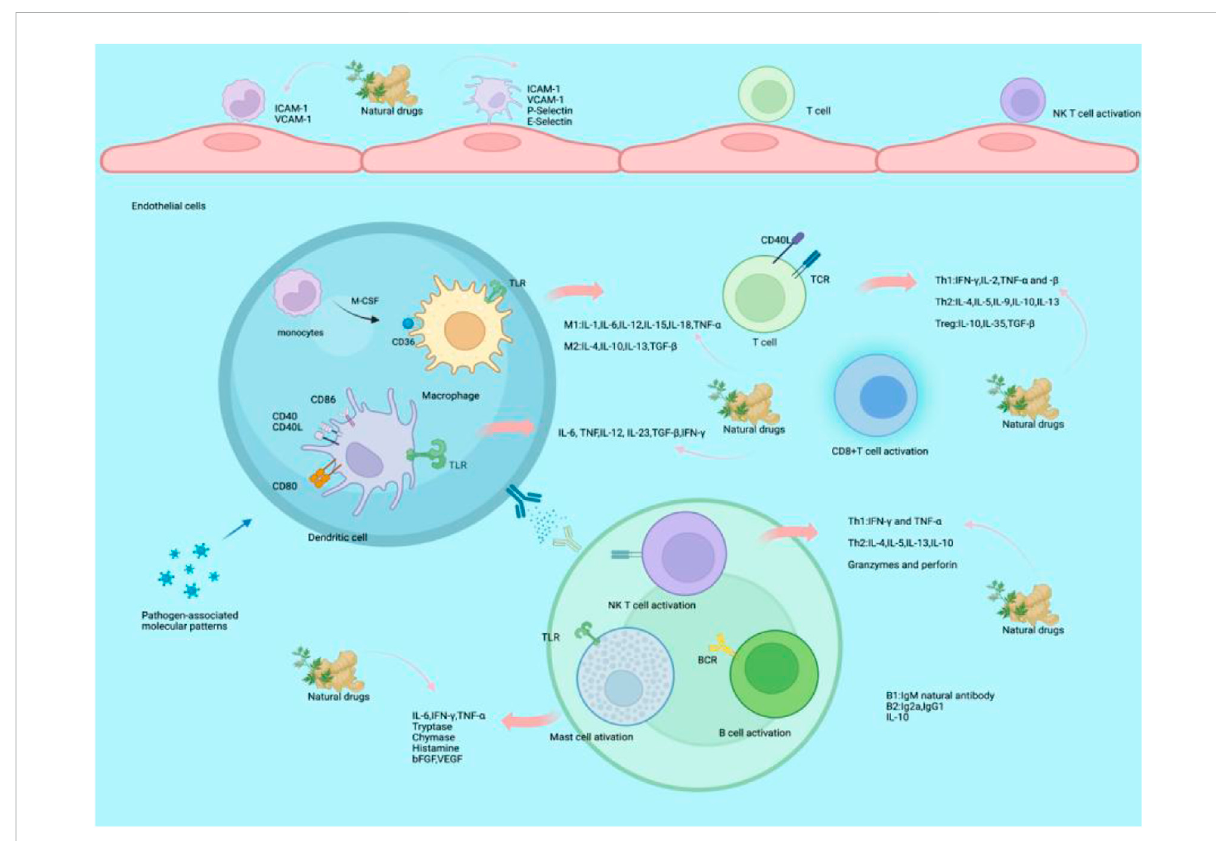
FIGURE 1 Mechanism of natural drugs on atherosclerotic in fl ammatory factors. At the early stage of AS, monocytes are tethered through the interaction between monocyte P-selectin glycoprotein-1 and endothelial P-selectin. With regard to adhesion and exudation, monocytes express very late antigen 4 (VLA4) and lymphocyte function-associated antigen-1 (LFA-1) to bind endothelial cell ligands, including VCAM-1 and ICAM-1. The monocytes differentiate into macrophages by M-CSF mediators. After activation, monocytes differentiate into two main phenotypes of macrophages:in fl ammatoryM1andregulatoryM2macrophages.M1macrophages producein fl ammationbysecretingpro-in fl ammatorycytokines after intake of modi fi ed LDL and present antigens to T cells through macrophages using pattern-recognition receptors (PRRs), resulting in releasing pro-in fl ammatory cytokines to activate T cells, including IL-1, IL-6, IL-12, IL-15, IL-18, MIF, and TNF- α . M2 macrophages have anti-in fl ammatory functions to address plaque in fl ammation through efferocytosis and the release of Th2 cytokines such as IL-4, IL-10, and